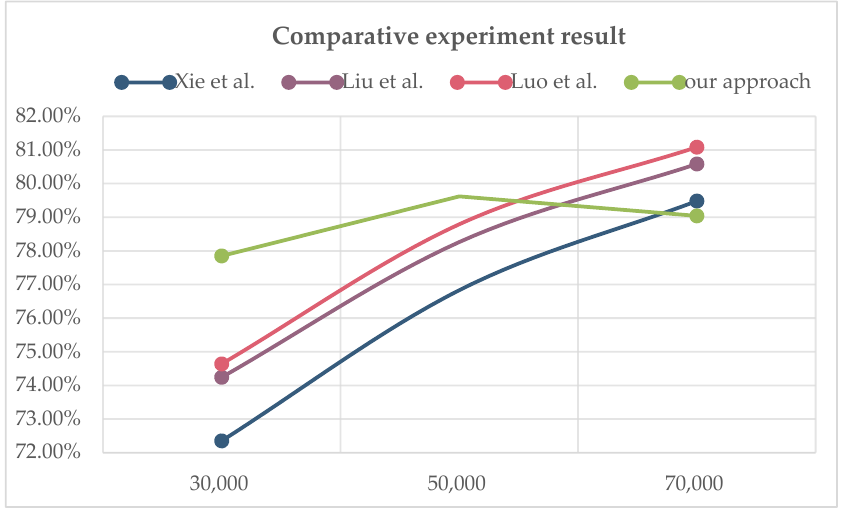
Figure 6. Experiment on the influence of knowledge vocabulary on answers.